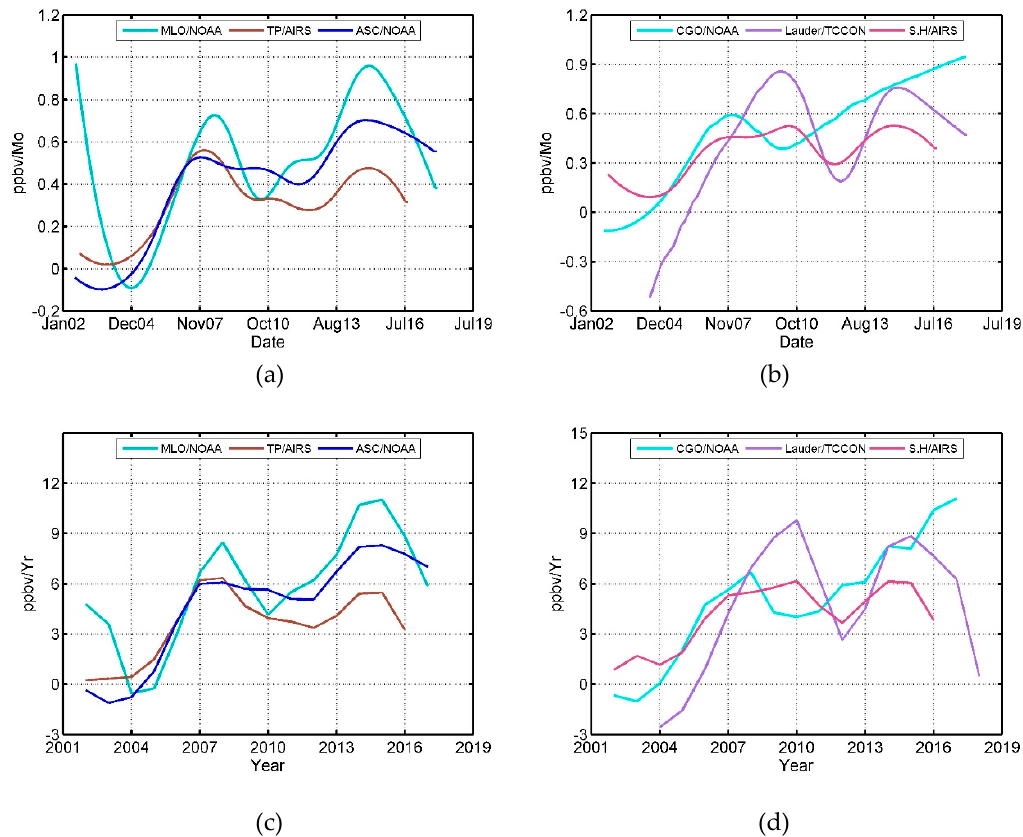
Figure 6. Comparisons of monthly and annual CH 4 increase rates (ppbv per month, ppbv/Mo and ppbv per year, ppbv/Yr) in the Tropics and Southern Hemisphere from AIRS, TCCON, and NOAA ground-based measurements. ( a ), ( c ) show monthly and annual AIRS CH 4 increase at 400 hPa over the Tropics (TP) region and surface CH 4 increase rates from two tropical NOAA stations; ( b ), ( d ) shows AIRS CH 4 increase rates over the southern Hemisphere, surface CH 4 from CGO/NOAA, and X CH4 from Lauder/TCCON.